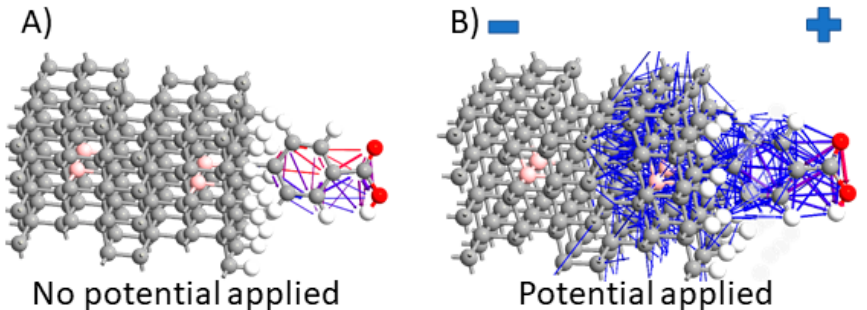
Figure 4. Electron pathways at the diamond surface modified by the attached linker (4-aminobenzoic acid): ( A ) structure without applied potential along C direction (from left to right), ( B ) structure with applied potential − 1V, ( − 0.5V on the left ( − ), 0.5V on the right side ( + )). The 2-terminal device structure was used (attn. electrodes are not shown here for figure readability).